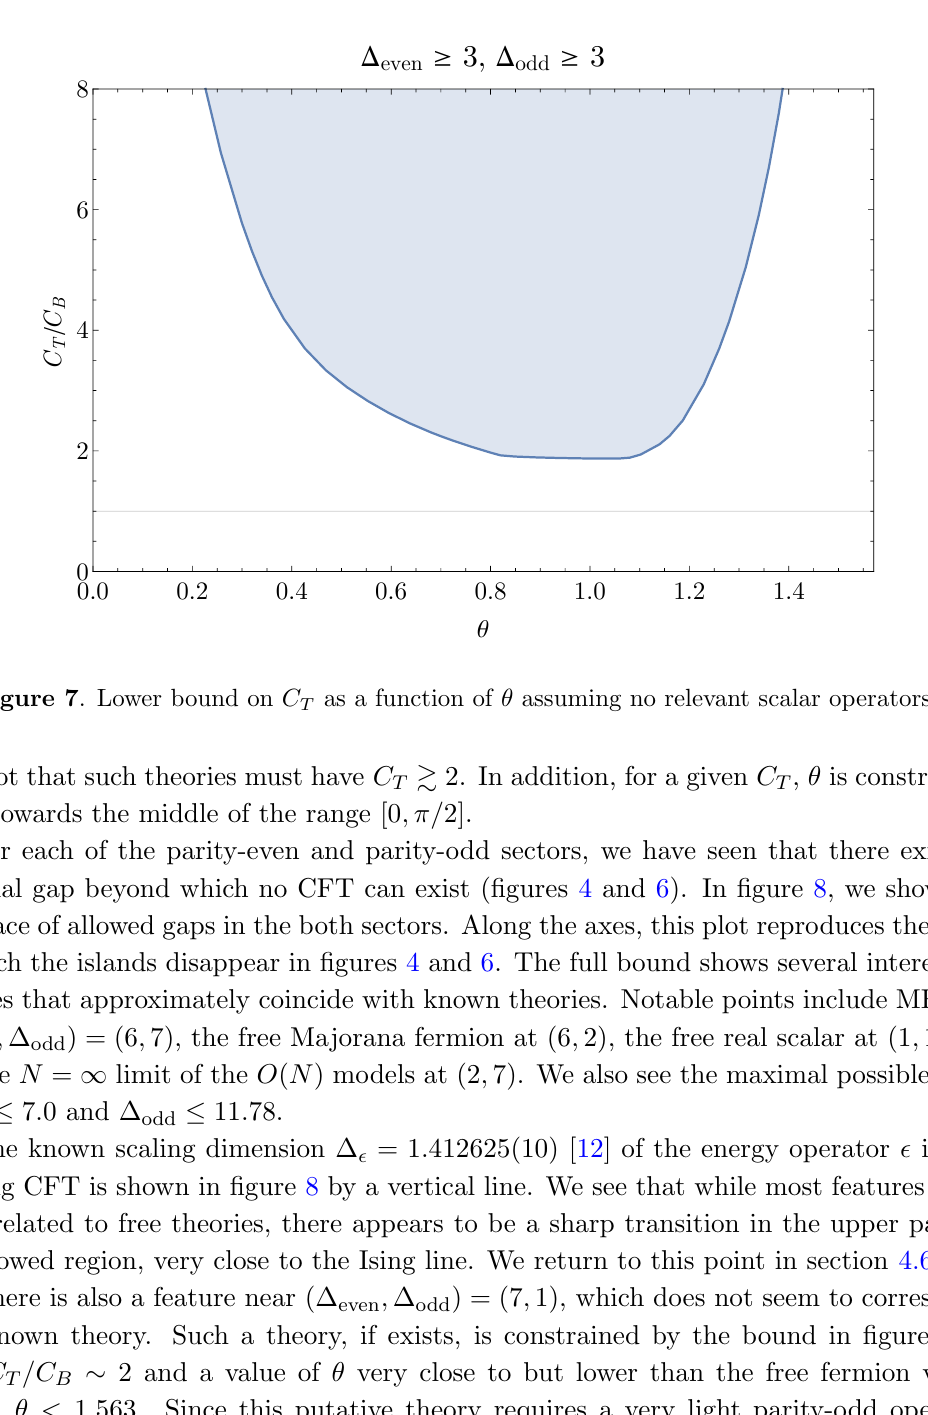
& 2. In addition, for a given C , (cid:18) is constrained T T